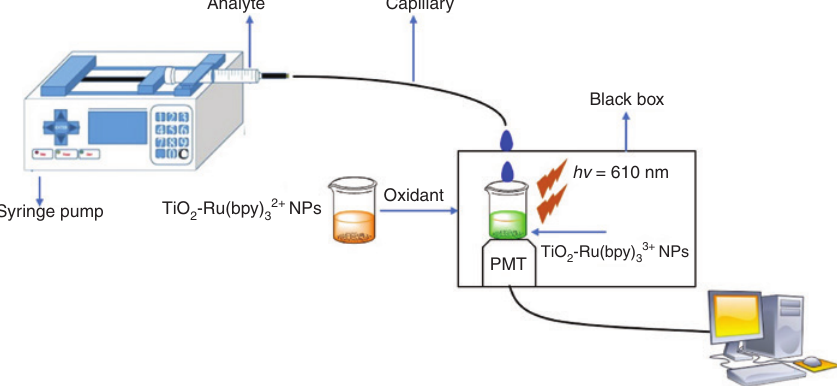
-Ru(bpy) 32 + solid-state CL 2